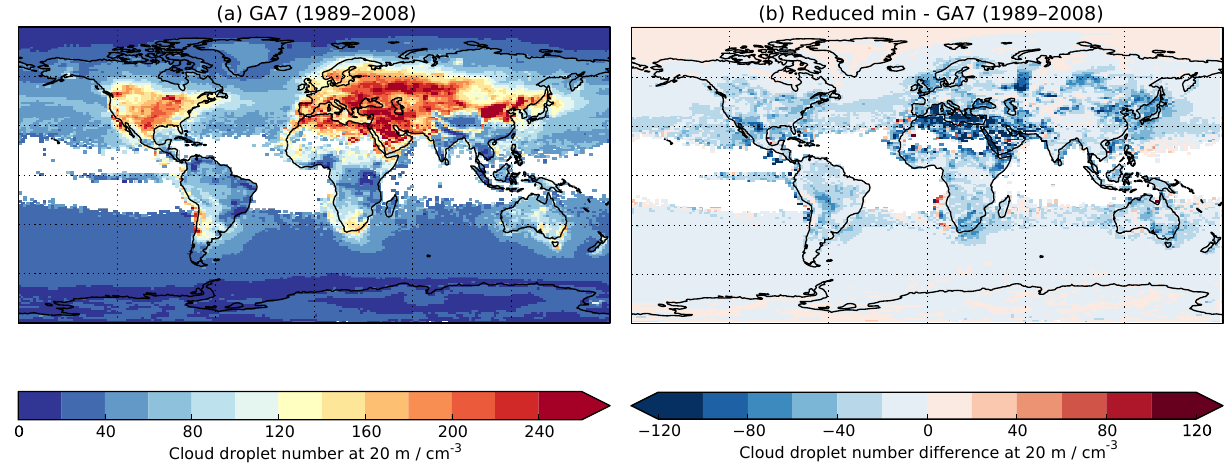
Figure 13. (a) 20-year mean cloud droplet number concentration at the lowest model level (20m) from an atmosphere only simulation of HadGEM3-GA7. (b) The difference from this when reducing the minimum updraught speed used for aerosol activation from 0.1 to 0.01ms − 1